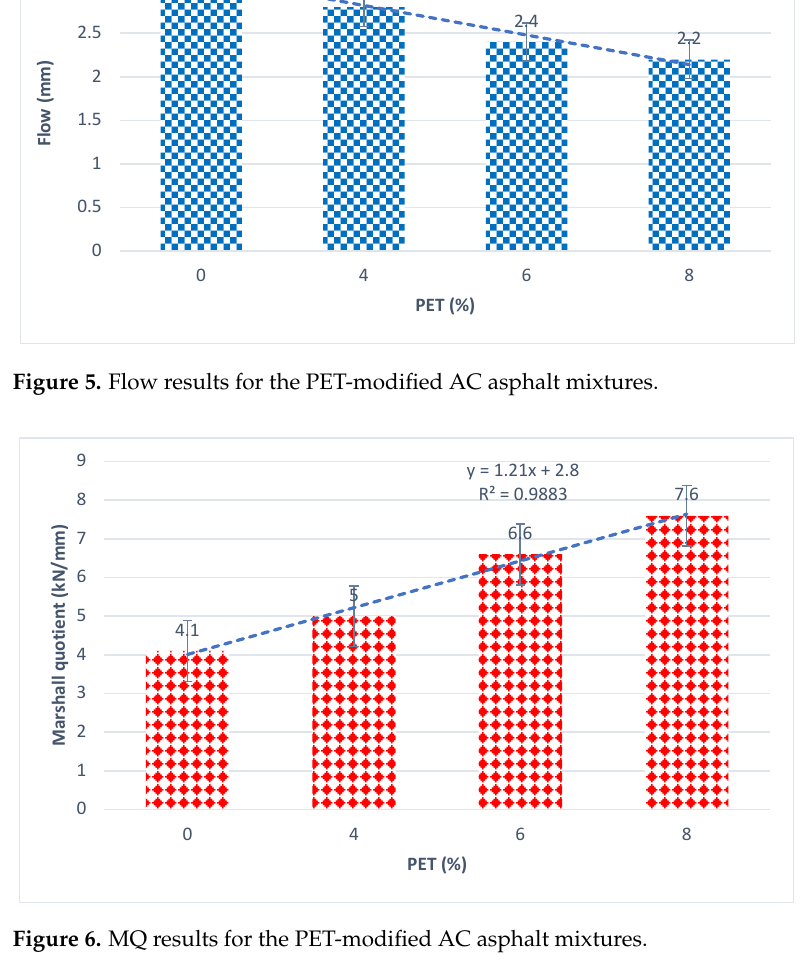
Figure 8. Flow of the PET-modified SMA asphalt mixtures.